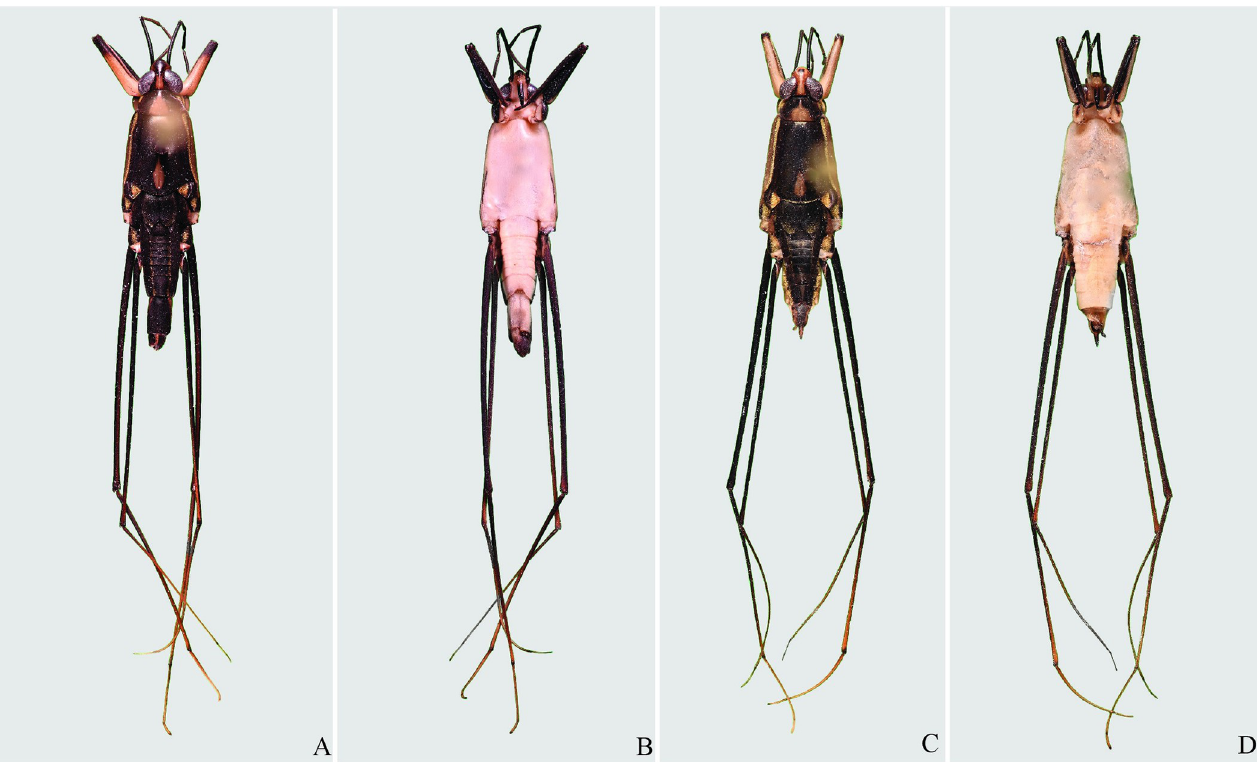
Fig 23. Potamobates manzanoae . (A) Male, dorsal view; (B) male, ventral view; (C) female, dorsal view; (D) female, ventral view. VIII : segment VIII; BS : basolateral process of proctiger; PR: Proctiger; PH : Phallus; PY: Pigophore; PJ: Projection of segment VIII; CS : Connexival spine; SVIII : Sternum VIII; AC : Anal cone; GN : Gonocoxae; DS : Dorsal sclerite of phallus; LS: lateral sclerite of phallus; TS: Transversal sclerite of phallus; AVS: Apex of ventral sclerite; BVS : Base of ventral sclerite; BDS : Base of ventral sclerite. basal margin notched (Fig 2D); lateral sclerite triangular; base of ventral sclerite not widened, notched centrally, apex almost twice as wide as center and notched centrally (Fig 2E); trans- verse sclerite smaller, not folded over ventral sclerite (Fig 2C). Abdominal tergum VIII and proctiger black; pygophore yellow to brown, ventrally blackish. Female : Abdominal lateroter- gites not folded over mediotergites; last segment without posterior projection (= connexival spine). Posterior margin of abdominal sternum VII produced posteriorly, extension oval, about three times as wide as long, partially covering first pair of gonocoxae, not folded over tergum VIII. Abdominal tergum VIII triangular, 1.6–1.8 times longer than wide, lateral mar- gins strongly converging posteriorly, apex acute. Anal cone long, about as long as abdominal tergum VIII. Extension of abdominal sternum VII yellowish. Dorsum of abdominal tergum VIII and anal cone black, lateral margins of tergum VIII, venter of anal cone and first pair of gonocoxae brown. Macropterous : posterolateral margin of pronotum brownish. Variation. Base of antenniferous tubercle might have a yellowish mark. Distal half of fore femur might be blackish. Comments. The male of P . bidentatus has the pygophore and proctiger weakly rotated, never reaching 45˚ (Fig 2A) in relation to the longitudinal axis of the body. A similar condition is found in P . horvathi , P . manzanoae , P . osborni , and P . unidentatus . However, while male P . bidentatus have two projections on the posteroventral margin of abdominal segment VIII (Fig 2A), the other species have only one projection.